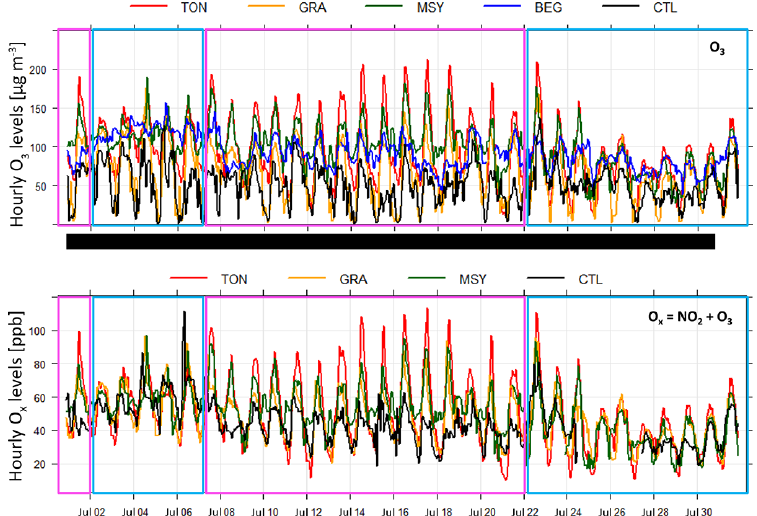
Figure 7. O 3 and O x (O 3 + NO 2 ) hourly concentrations recorded at the coastal (BEG, blue, at this site only O 3 is available due to the lack of NO 2 measurements), an urban background site of Barcelona (CTL, black), an urban site in the northern periphery of Barcelona metropolitan area (GRA, orange), the intermediate inland rural site of MSY (720ma.s.l., green), and the inner Vic Plain site (TON, red) during July 2015. The pink and blue squares mark the A and B O 3 and O x episodes distinguished in this study,